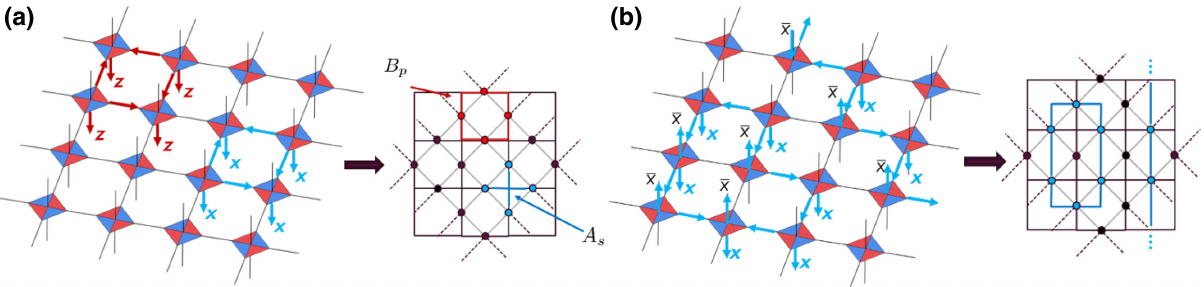
FIG. 7. (a) One can recover the star A s and plaquette B p operators by pushing the stabilizers of local tensor modules. (b) Similarly, one can push through a combination of stabilizers and logical operators to obtain closed contractible loops (stabilizers and logical identity) and uncontractible loops (logical operators). The lattice of the tensor network is rotated by 45 ◦ relative to the conventional toric code lattice. When the tensor network is overlaid with the toric code lattice, we view the network from the top down such that the logical legs point out of the page and the physical legs point into the page. A vertex on the toric code lattice is colored red (or blue) if a Z (or X ) acts on the physical